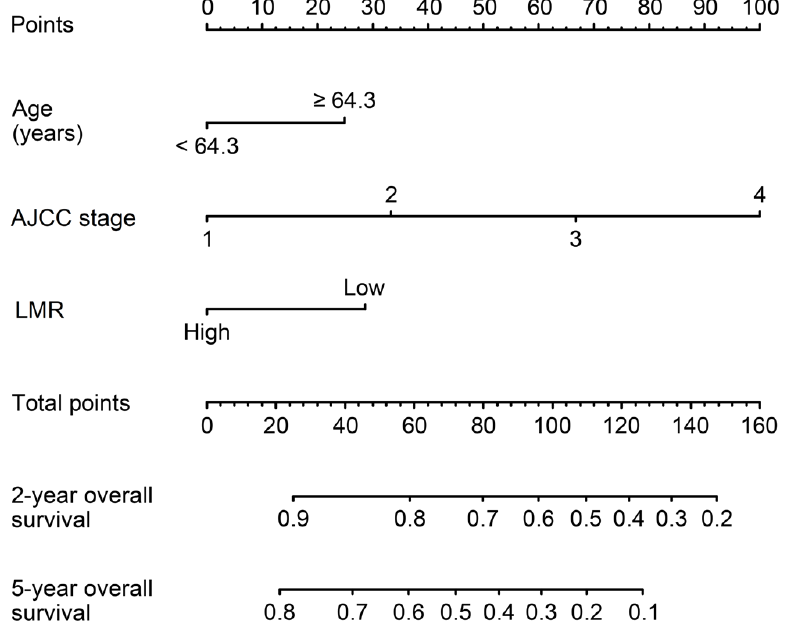
Figure 6. Nomogram for overall survival of patients with stage I/II non-small cell carcinoma. LMR— lymphocyte–monocyte ratio.